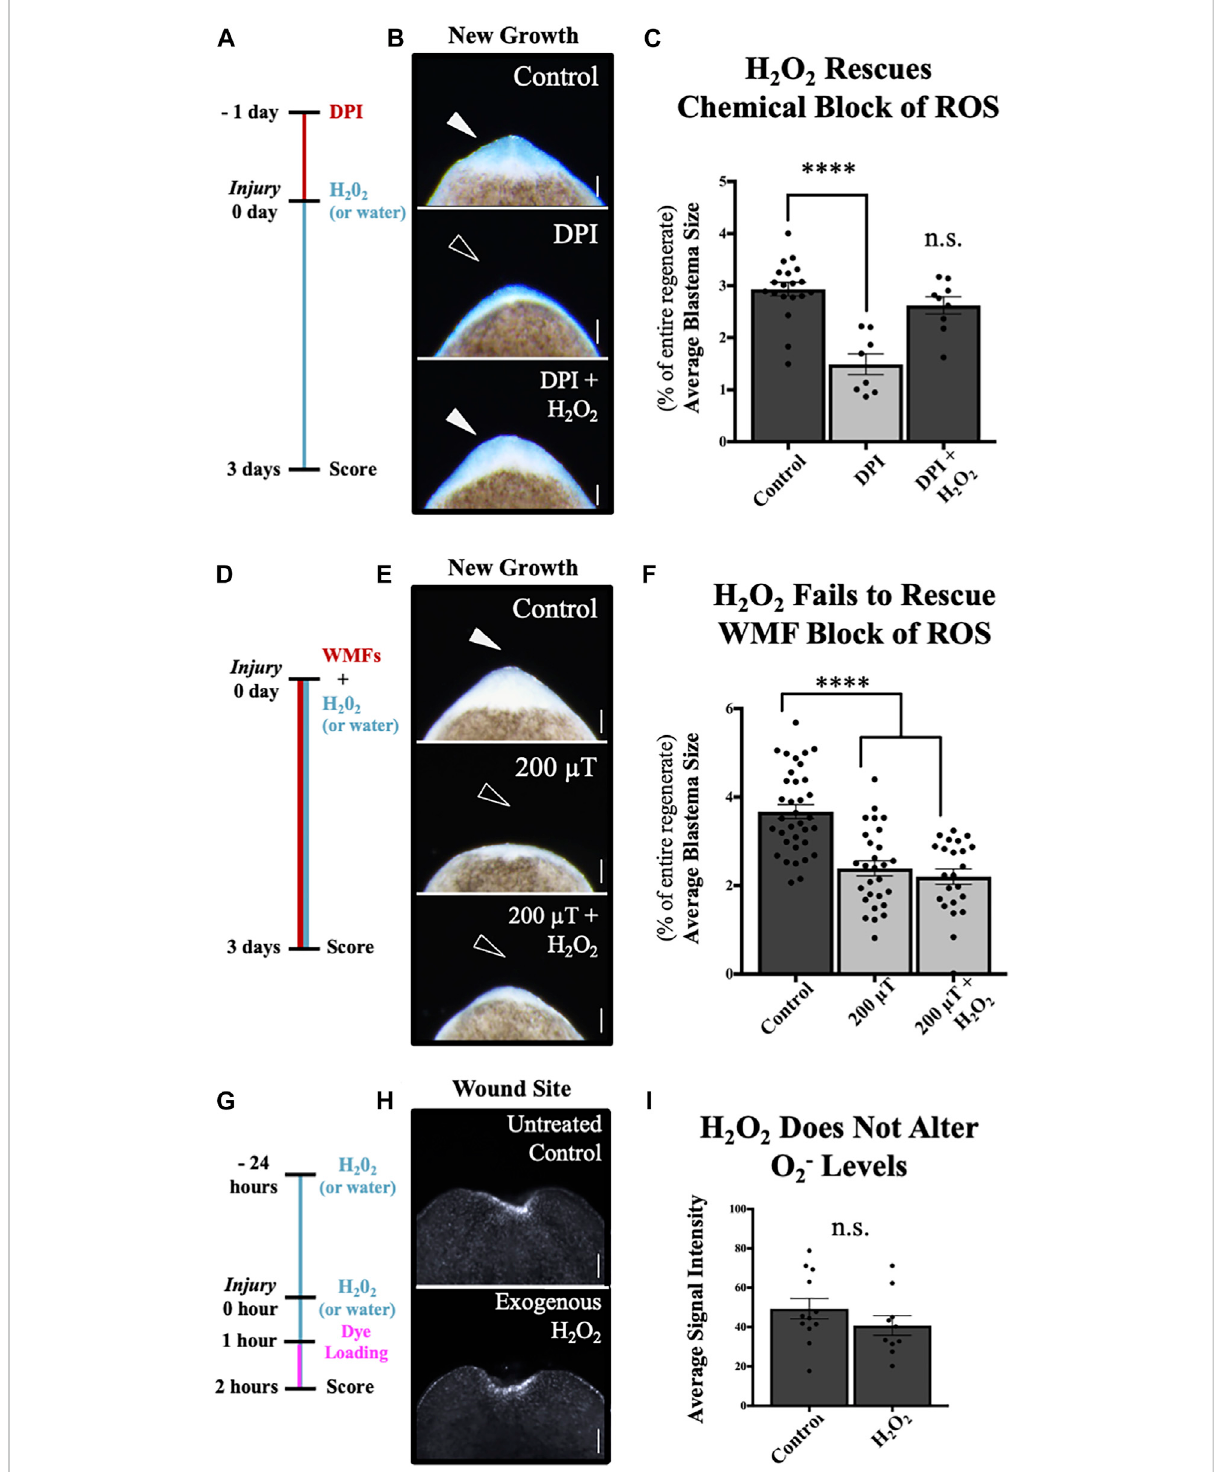
FIGURE 6 H 2 O 2 RescuesChemical,butnotWMF,InhibitionofTissueGrowth.Newtissueandsuperoxidelevelsattheanteriorwoundsite. (A – C) Blastema sizeat3dayspostinjuryafter chemical inhibitionofROSby10 μ Mdiphenyleneiodonium(DPI),anNAD(P)Hoxidaseinhibitor. (A) Treatmentscheme. Animals were pre-treated for 24 h prior to injury, then amputated. All regenerates were returned to untreated worm water, except for DPI + H 2 O 2 animals, which were then placed in 400 μ M H 2 O 2 until scoring. Controls = vehicle control (DMSO only). (B) Images of new tissue growth. (C)